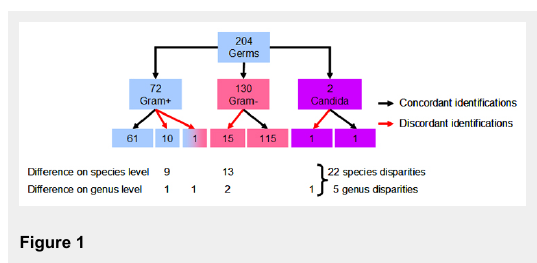
Clinical isolate characterisation listed by organism group and MALDI identification